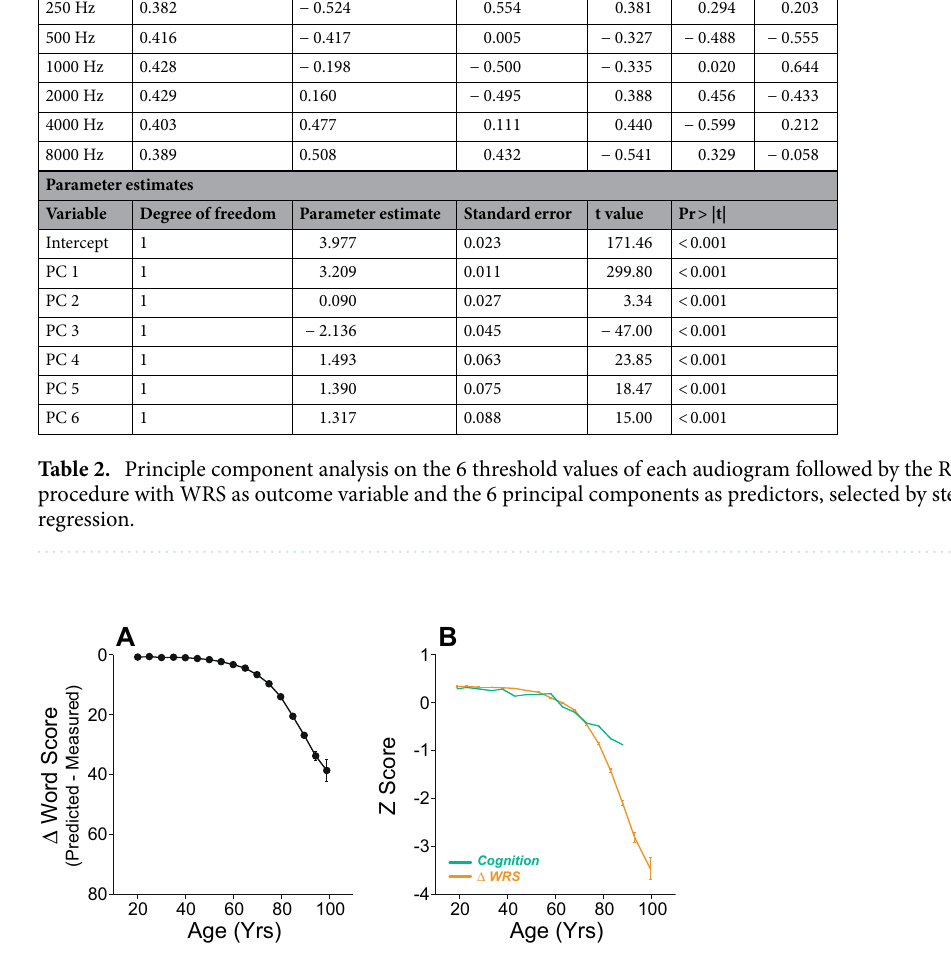
Figure 7. Intelligibility worsens with age independently of cognition. ( A ) Intelligibility deficits assessed as differences between measured and predicted word scores as a function of age. ( B ) Comparison of intelligibility deficits measured in ( A ) with working memory assessed using the Wechsler Adult Intelligence Scale (WAIS) as a function of age. To compare these two tests, data from each have been converted to Z-scores. Error bars are standard error of